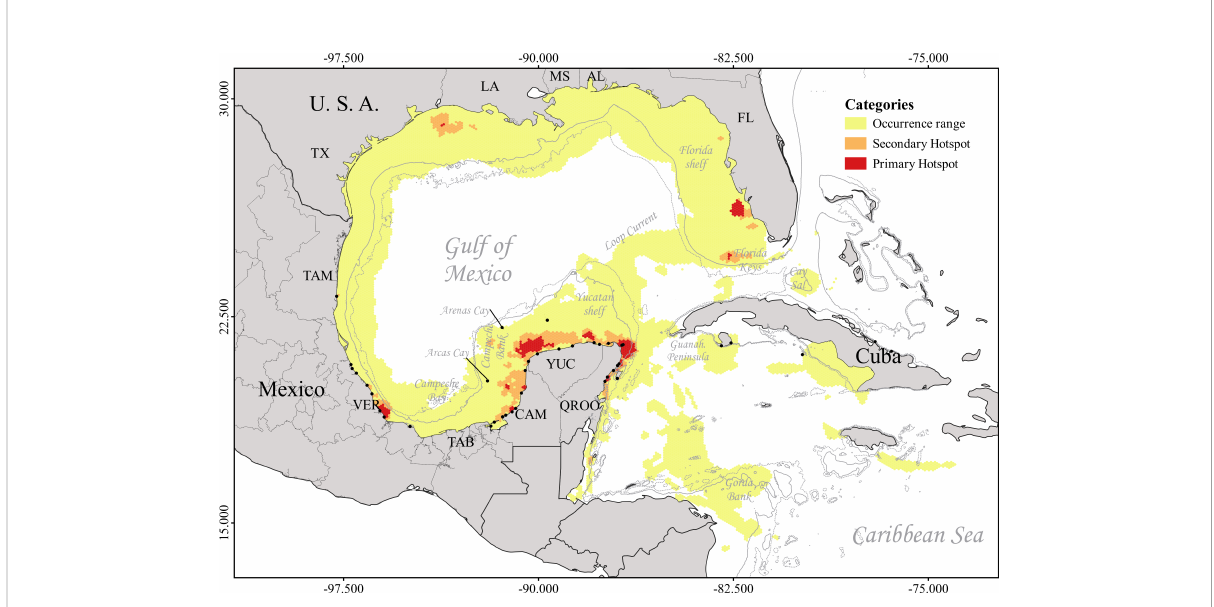
FIGURE 3 Multispecies and multi-life stage hotspots in the Gulf of Mexico and Mesoamerican Reef. Continuous thin gray line depicts the 200 m isobath, and the dashed thin line depicts the 500 m isobath (https://www.gebco.net/). Black dots represent the releasing sites of the satellite-tracked